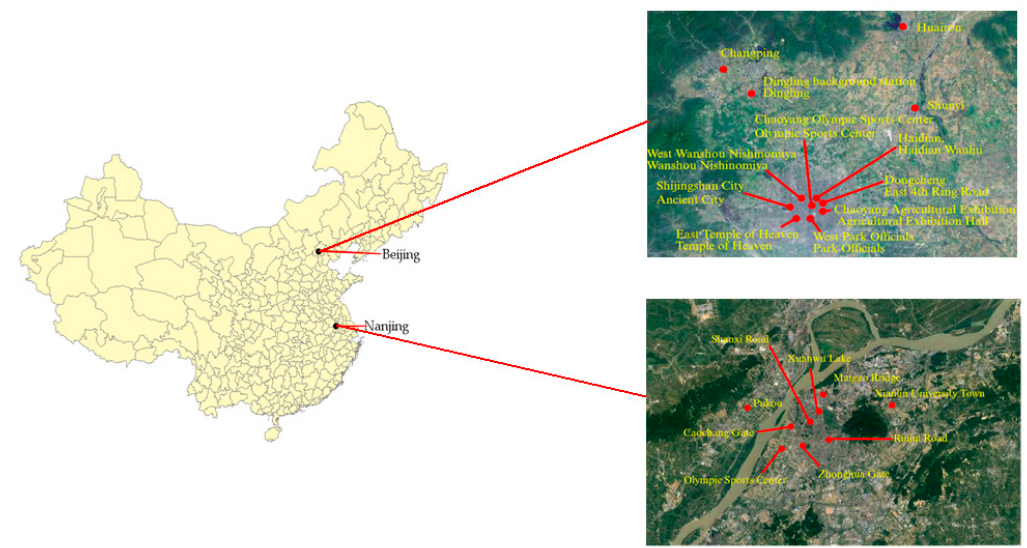
Figure 1. Sampling sites in Beijing and Nanjing on Google maps.